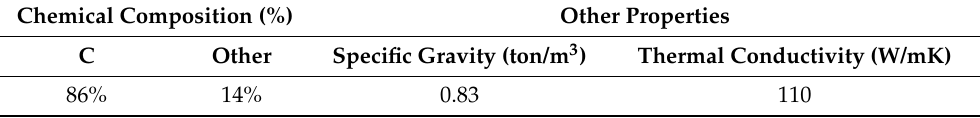
Table 2. Properties of graphite.